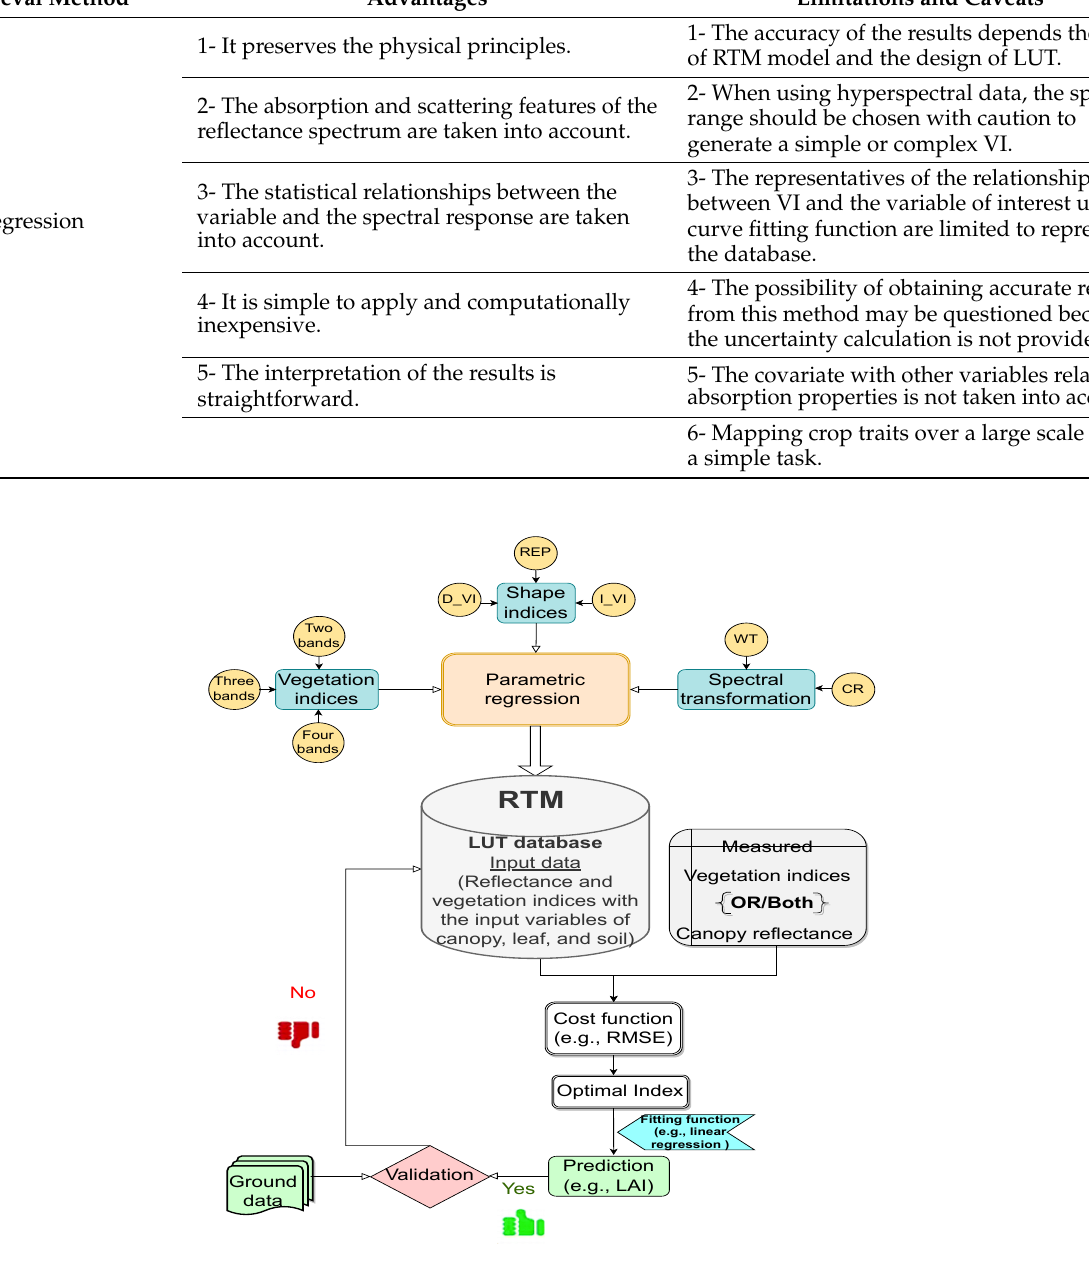
Figure 2. Workflow diagram of parametric algorithms in the hybrid